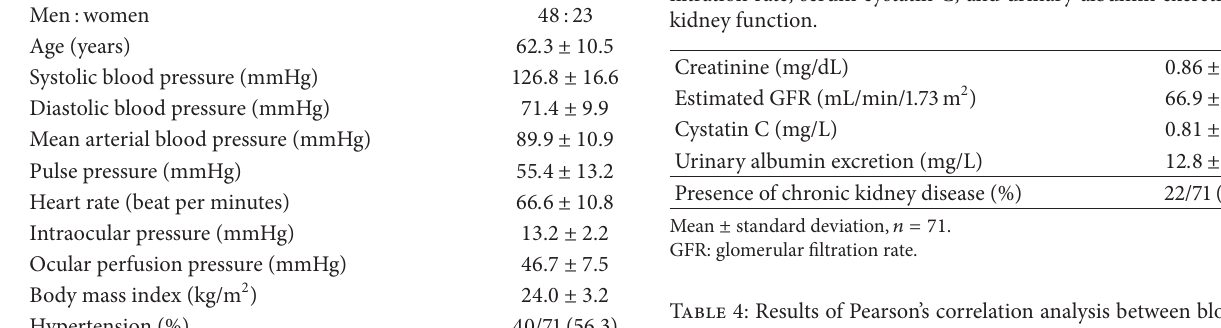
Table 1: Characteristics of subjects.